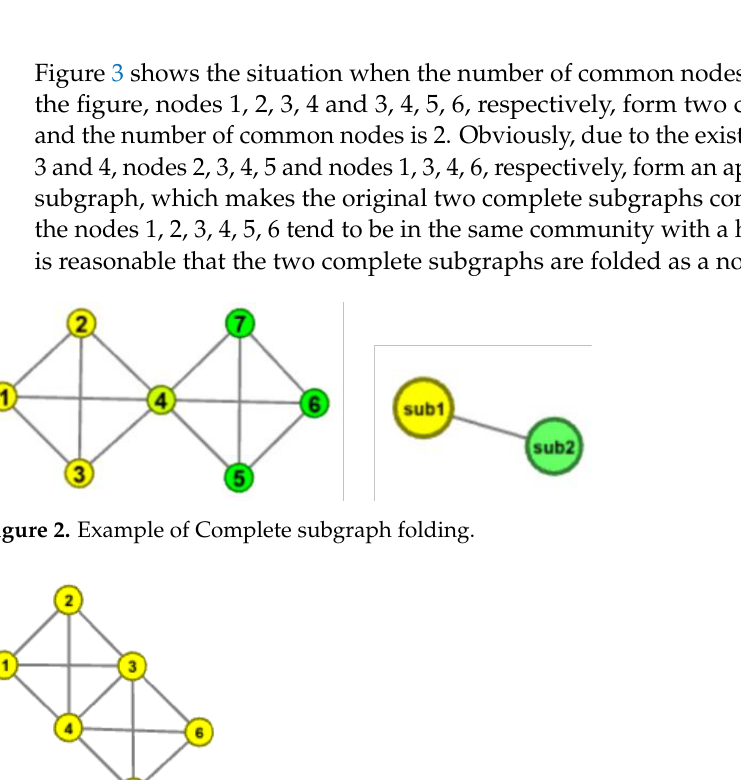
Figure 3. Example of complete subgraph folding.